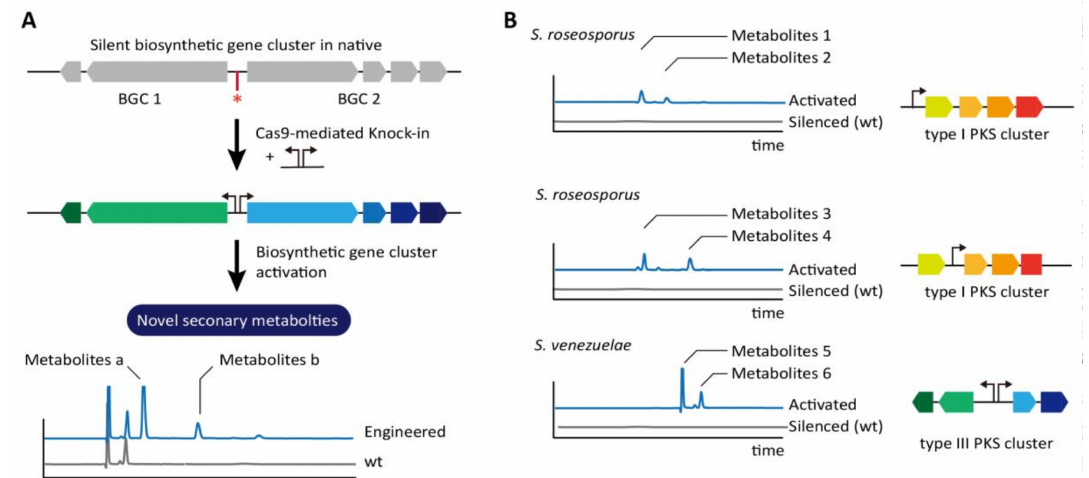
Figure 4. Identification of novel metabolites through insertion of synthetic promoter in the upstream of silent biosynthetic gene cluster (BGC) in native ( A ) Using CRISPR-Cas9, efficient and precise introduction of promoter cassettes (red-shaded arrows) induces the expression of biosynthetic genes and triggers the production of unique metabolites that are not detected in the wild-type strain. The asterisk indicates DSB-dependent modified region. ( B ) The metabolites of different type are shown according to the promoter insertion location in type I PKS cluster in S . roseosporus . In S . venezuelae , the insertion of a bidirectional promoter cassette between a type III PKS gene encoding an RppA synthase and a cytochrome P450 gene resulted in production of novel pigmented products